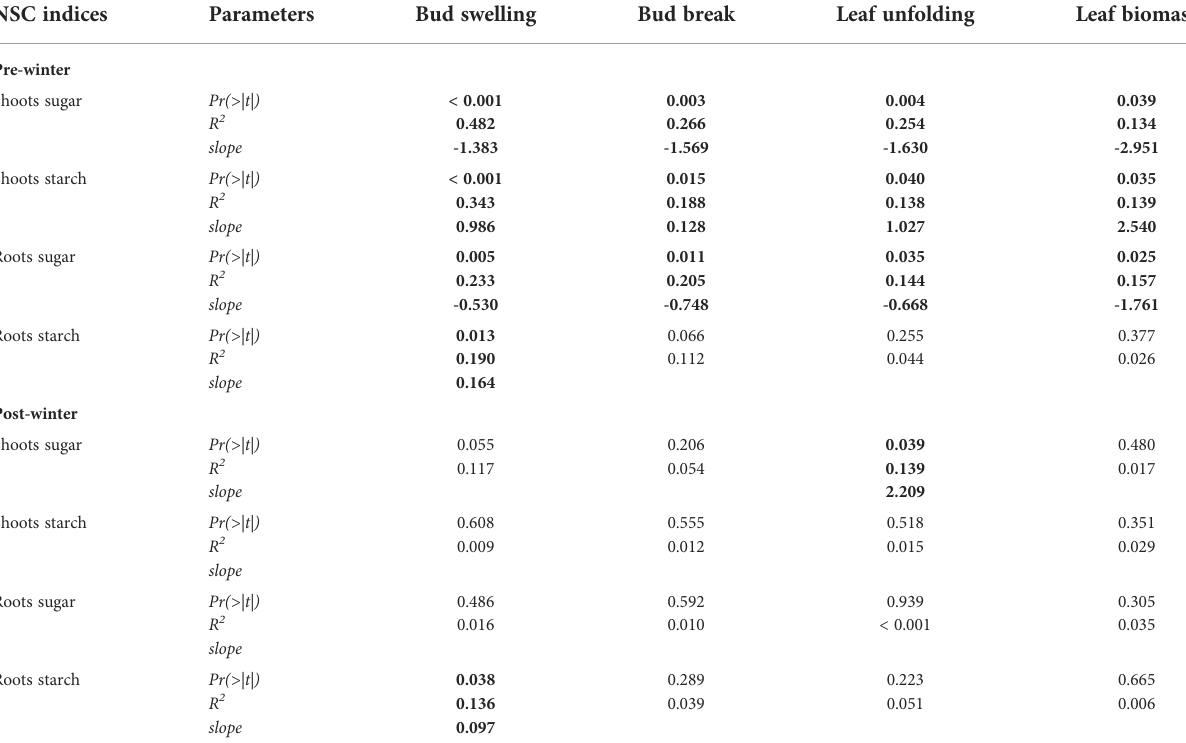
TABLE 2 Correlation between the number of days until different leaf development stages and leaf biomass in relation to non-structural carbohydrate (NSC) concentrations in shoots and roots at pre- and